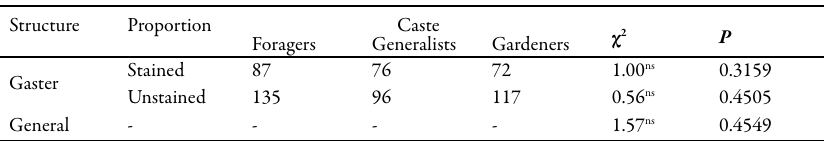
Table 1- Proportion of A. capiguara workers by caste with gaster stained and unstained after application of baits with Rhodamine-B dye. ns: Not significant by Chi-Square test (P<0.05). Structure